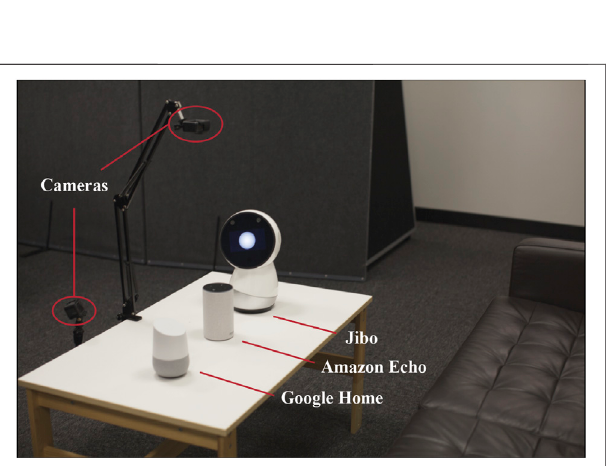
Frontiers in Robotics and AI |